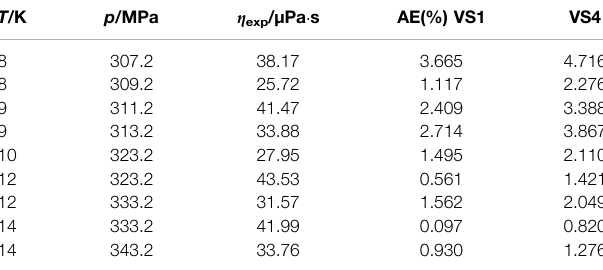
TABLE 3 | Comparison between the predicted and experimental data in pseudocritical region. T